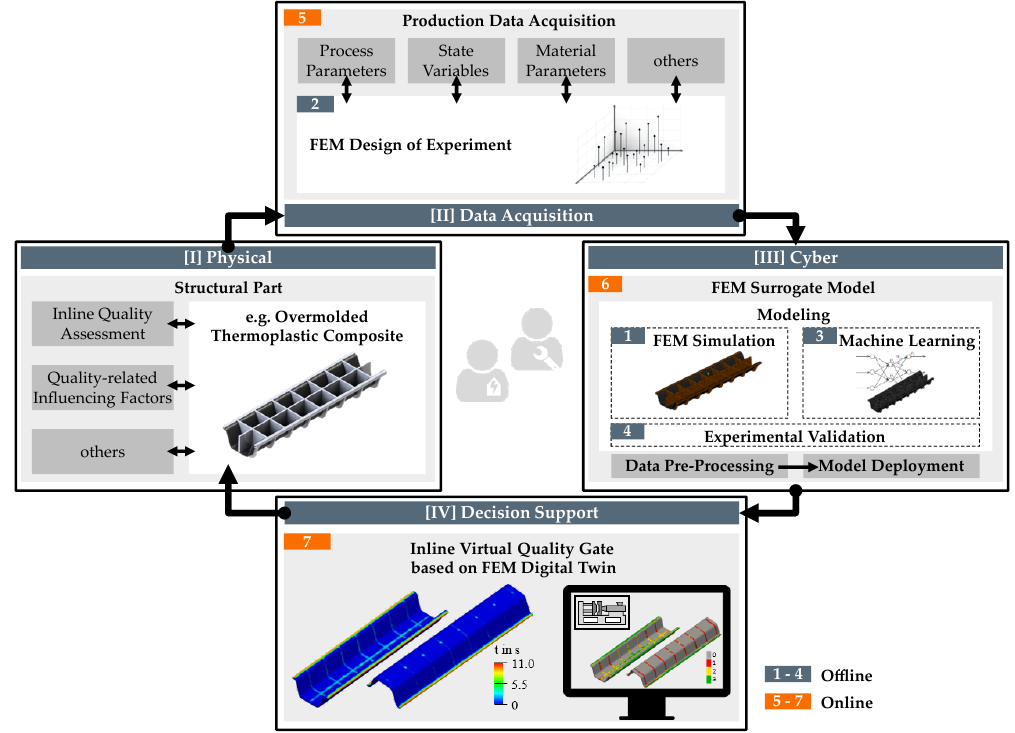
Figure 2. Cyber physical production systems (CPPS) based framework for a digital twin using Finite-Element-Method (FEM) simulation and machine learning for surrogate modeling; adapted from Thiede et al.